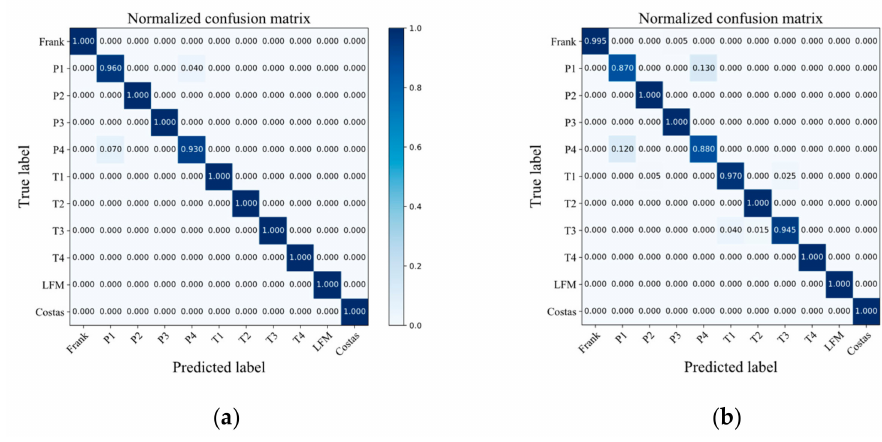
Figure 17. Confusion Matrix of MFIJD on 0 dB Test Set: ( a ) Structure 1. ( b ) Structure